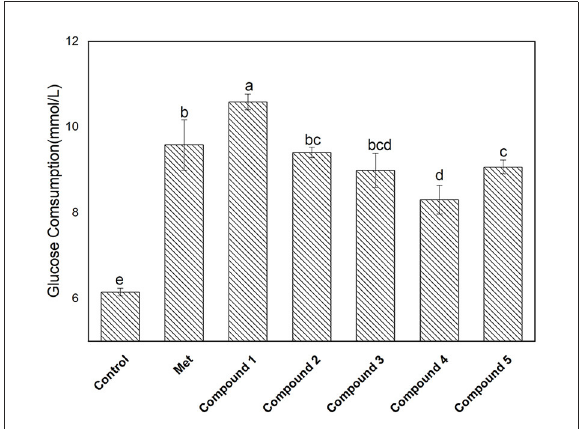
FIGURE5 Glucose consumption activity of isolated compounds 1 – 5 with a concentration of 0.18 mg/L. The values with different small letters (a–e) indicate a significant difference between different groups at p <